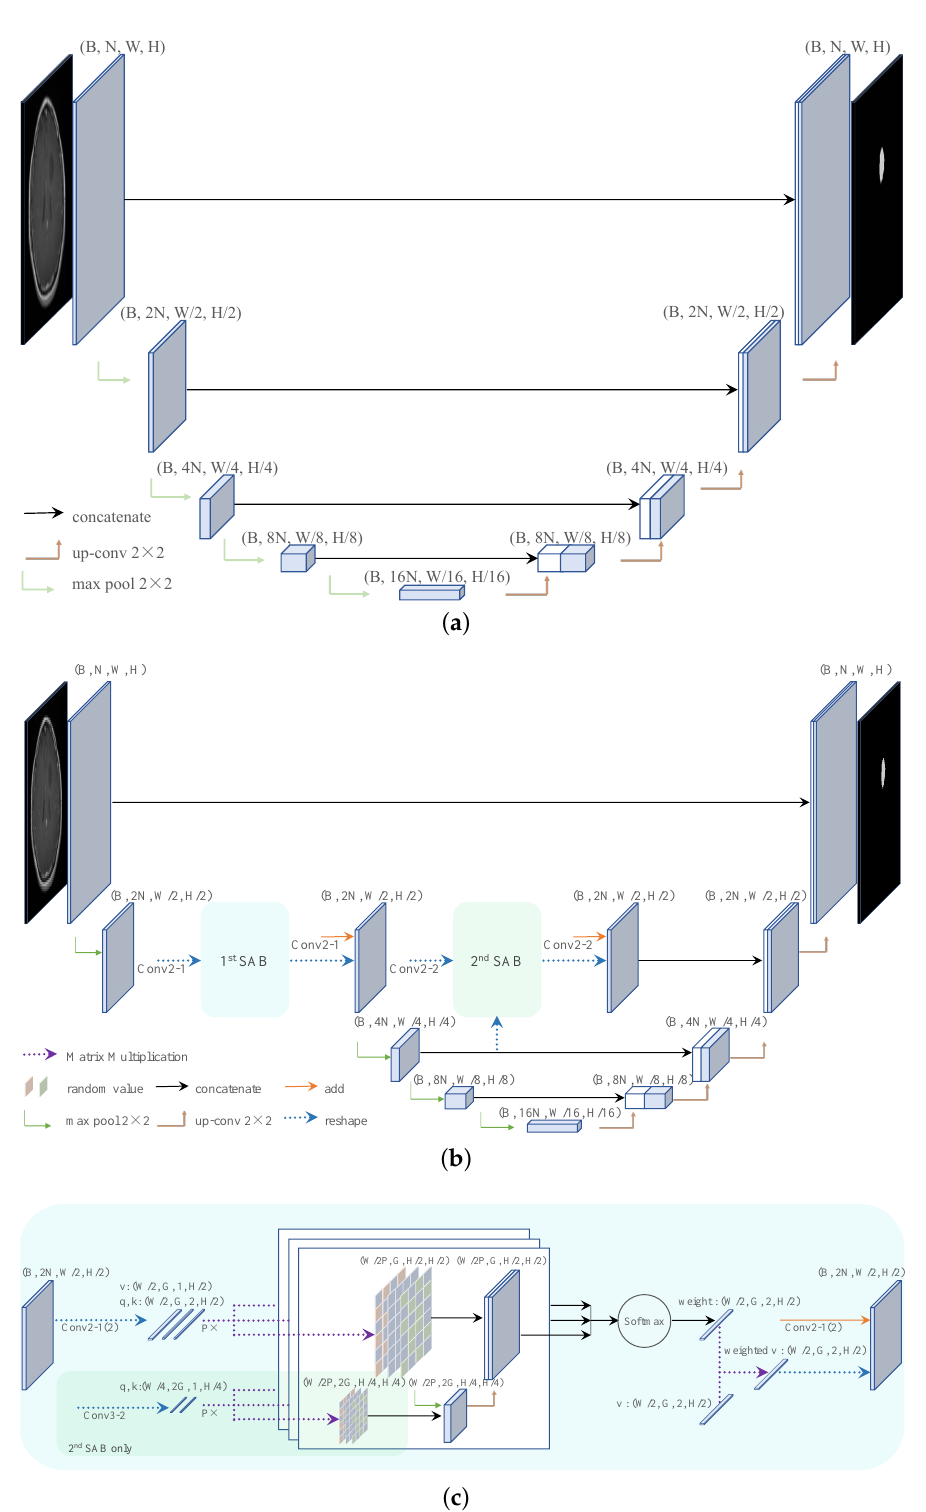
Figure 1. ( a ) U-Net; ( b ) an example of an SAB network. Each blue box corresponds to a multichannel feature map. The size is provided on top of the associated box. B, N, W, H, and G represent the batch size, number of channels, width, height, and group, respectively. ( c ) The details of the